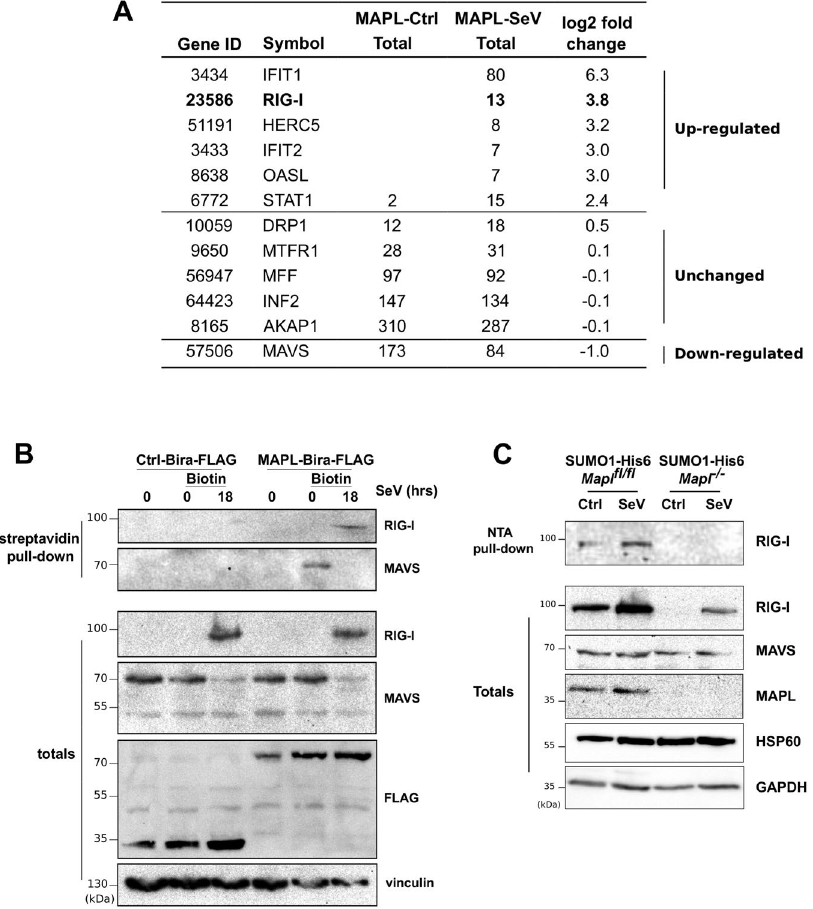
Figure 4. Biotin-labeled interaction landscape identifies RIG-I as a MAPL substrate upon Sendai infection. ( A ) HEK293 cells stably expressing an inducible Tet-ON fusion construct MAPL-BirA-FLAG or Ctrl-BirA- FLAG were induced with tetracycline for 9 hours, and infected (or not) with Sendai virus in the presence of excess biotin within the media for a further 15 hours. Biotinylated proteins were isolated and sequenced by mass spectrometry. Shown are total peptide counts observed for the indicated proteins. Selected proteins showing a greater than 2 fold change in the presence of Sendai virus are shown, along with the top MAPL binding partners related to mitochondrial fission as control. Full dataset is in Supplemental Fig. 2. ( B ) Cells were infected with Sendai virus for 18 hours and tagged proteins were isolated on streptavidin-sepharose and immunoblotted. (C) Stable His6-SUMO1 Mapl fl/fl and Mapl − / − MEFs were infected with Sendai virus for 18 hours, lysed, and SUMOylated proteins were isolated on Ni-NTA beads and